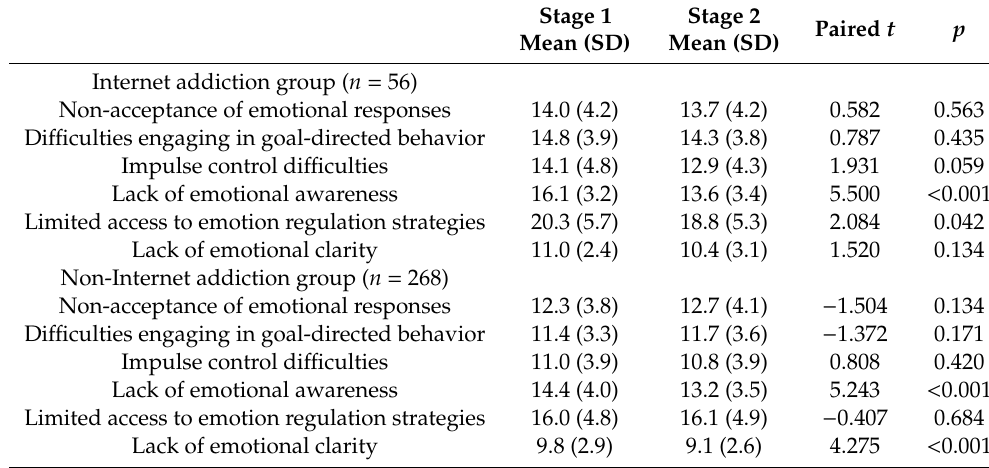
Table 4. Comparisons of di ffi culties in emotion regulation between the initial (Stage 1) and follow-up (Stage 2) investigations among the participants with and without Internet addiction at Stage